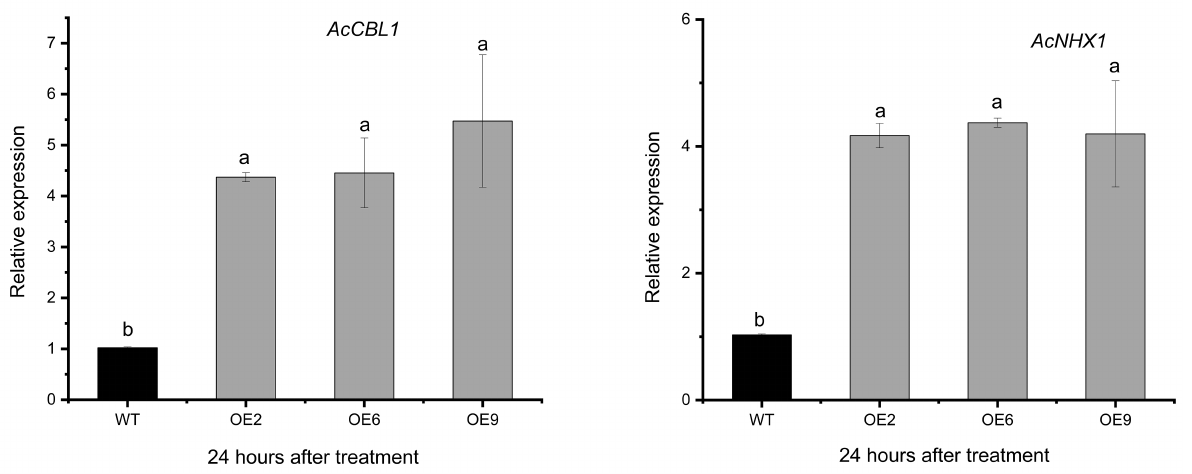
Figure 8. Expression analysis of AcCBL1 and AcNHX1 in OE plants. WT: ‘Hongyang’ kiwifruit; OE2, OE6, and OE9 repression the three transgene lines. Different letters (a–b) represent significant mean differences at p